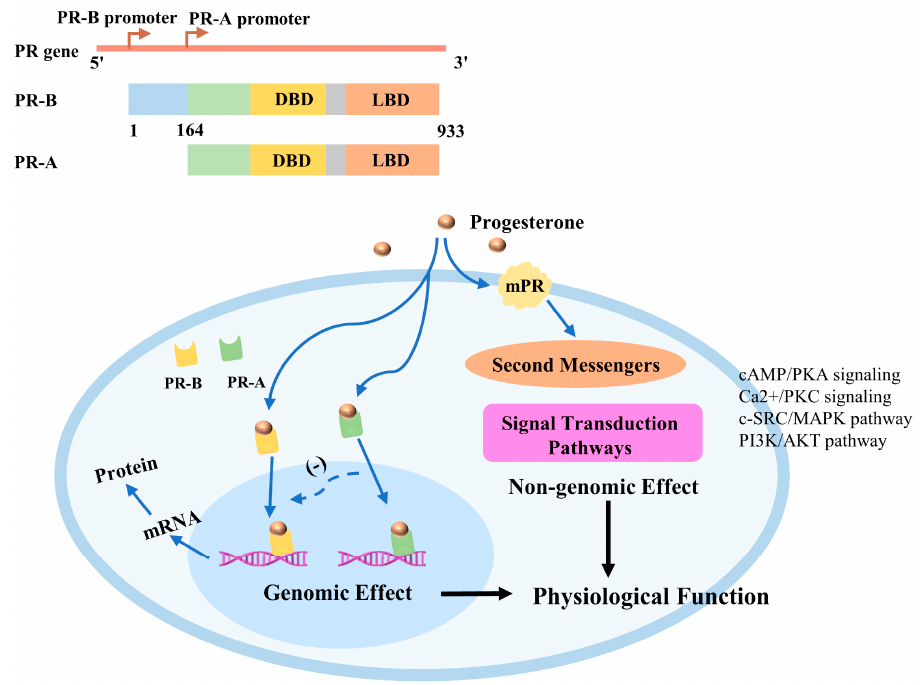
Figure 1. Mechanism of progesterone action. Progesterone effects are primarily mediated by the classical signaling pathway that progesterone receptors bind the ligand and then translocate to the